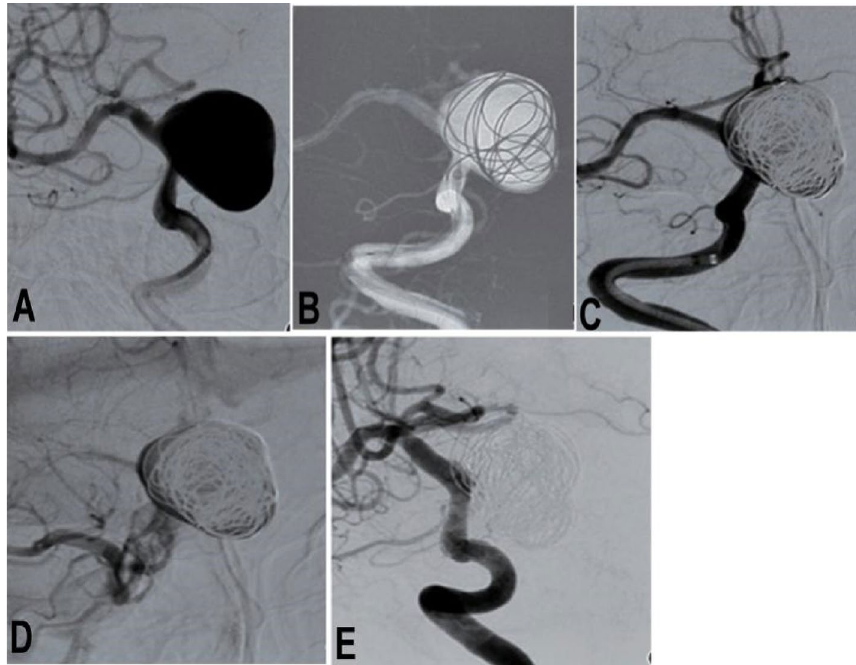
Figure 1. A patient with a giant aneurysm at the right internal carotid artery ophthalmic segment was treated with a Pipeline embolization device combined with coil embolization. ( A ) Before endovascular procedure, the giant aneurysm was shown. ( B ) The aneurysm was firstly partially embolized with coils to promote thrombosis within the aneurysm sac and prevent possible aneurysm rupture before deployment of the Pipeline device. ( C ) After embolization, angiography revealed contrast filling inside the aneurysm sac. ( D ) In the venous phase, the contrast agent within the aneurysm was retained. ( E ) Follow-up angiography 4 months later showed complete occlusion of the